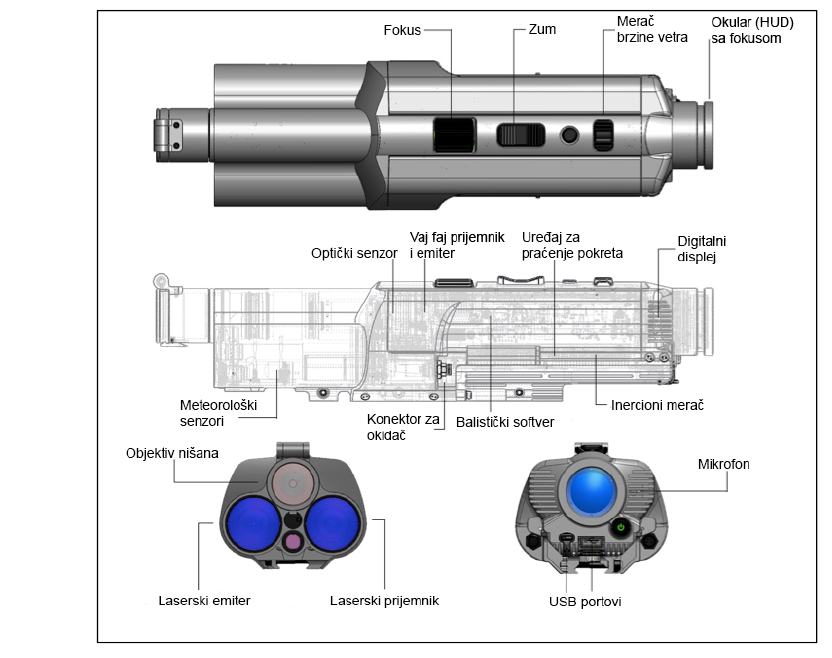
ka na daljinama iznad 1000